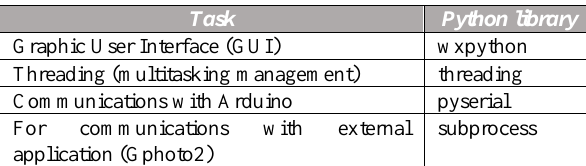
Table 3. Python libraries used in